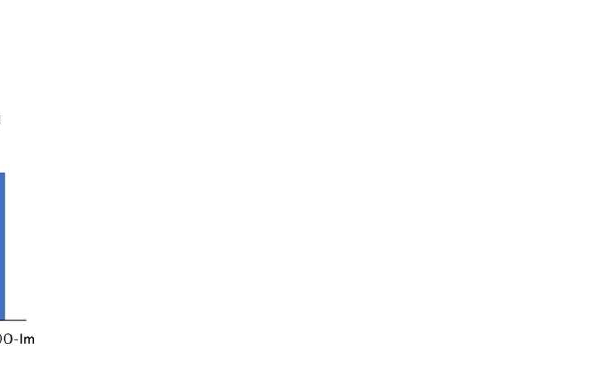
Figure 6. The expression of antioxidants ( Hmox1 and Nqo1 ) in retina of CDDO-Im-treated mice. Mice received vehicle or CDDO-Im on days 0, 2, 4, 6, 8, 10, 12, and 14, and eyes were enucleated on day 14. The expression of ( Hmox1 and Nqo1 ) in retina was examined by quantitative PCR. The mean ± standard deviation for each group ( n = 6 mice per group) is shown. Asterisk indicates p < 0.05 versus vehicle-treated mice. Statistical analysis was performed according to Student’s t test.